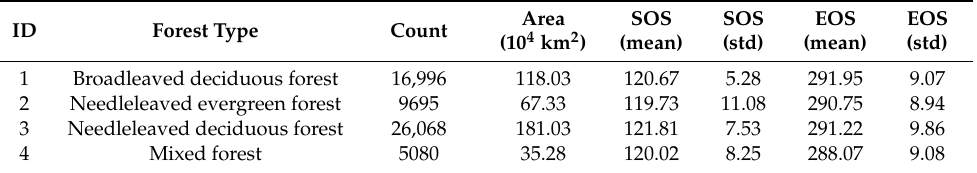
Figure 2. Spatial distribution of start date of the growing season (SOS, a ) and the end date of the season (EOS, b ) in the China–Mongolia–Russia International Economic Corridor. Table 1. The mean and standard deviation of start date (SOS) and the end date (EOS) of the growing season for di ff erent forests